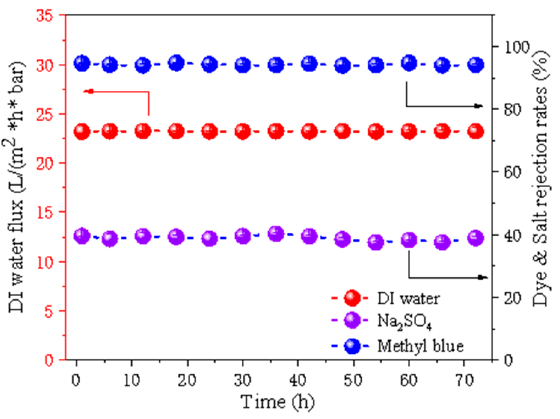
Figure 8. The long-time stability of 7.5% nano-BC/Kevlar membrane.